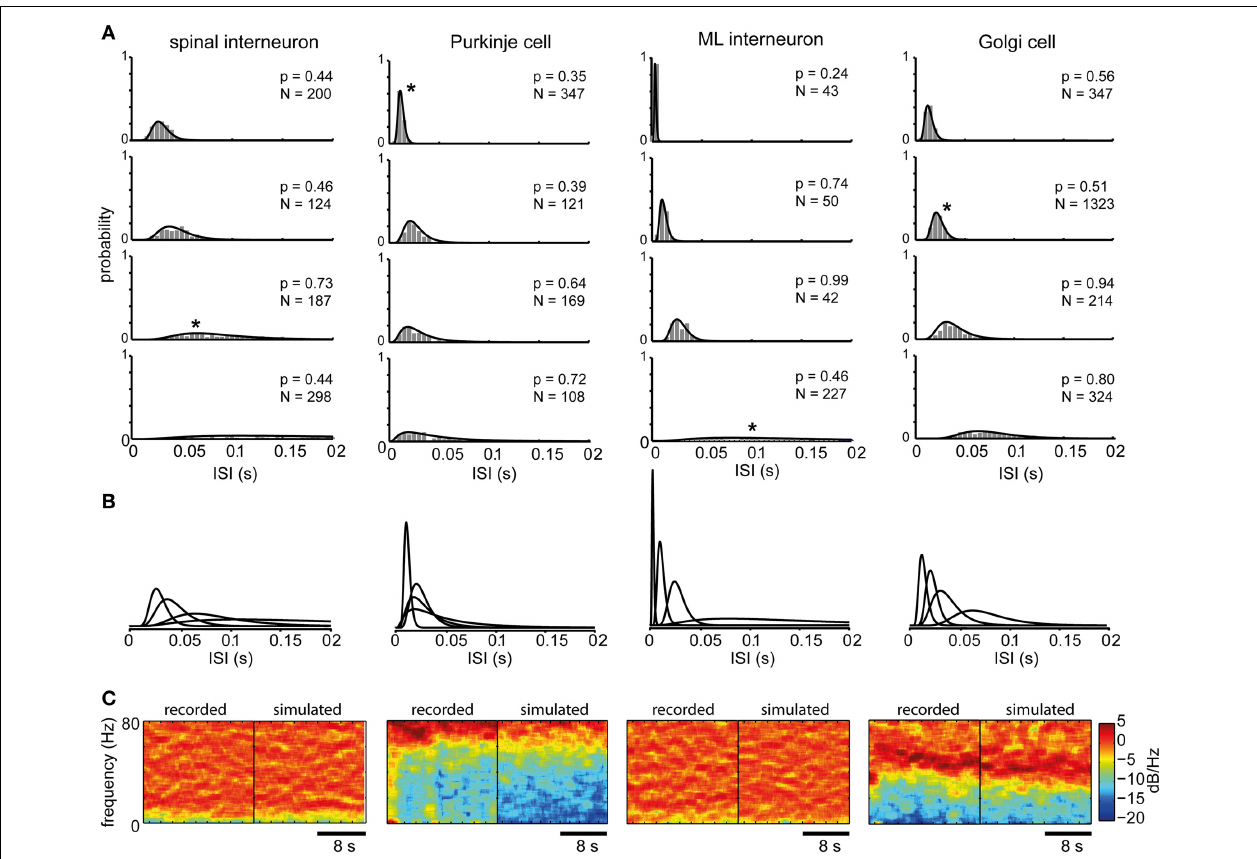
FIGURE 2 | ISI distributions at different firing levels for different types of neurons. (A) The spike firing probability at four different firing levels (shown in ISI histograms with 5ms bin width) and the maximum likelihood log-normal distribution for the cell type indicated at the top. Note that the x-axis is truncated at 200ms, whereas many interspike intervals at the lowest firing levels could occur outside this range. N indicates the number of spikes in each histogram and the p -values above each histogram is given by the AD-test. A low p -value would mean that the null hypothesis that the ISIs originate from the log-normal distributions should be rejected, which is not the case in any of the shown distributions. (B) The fitted log-normal